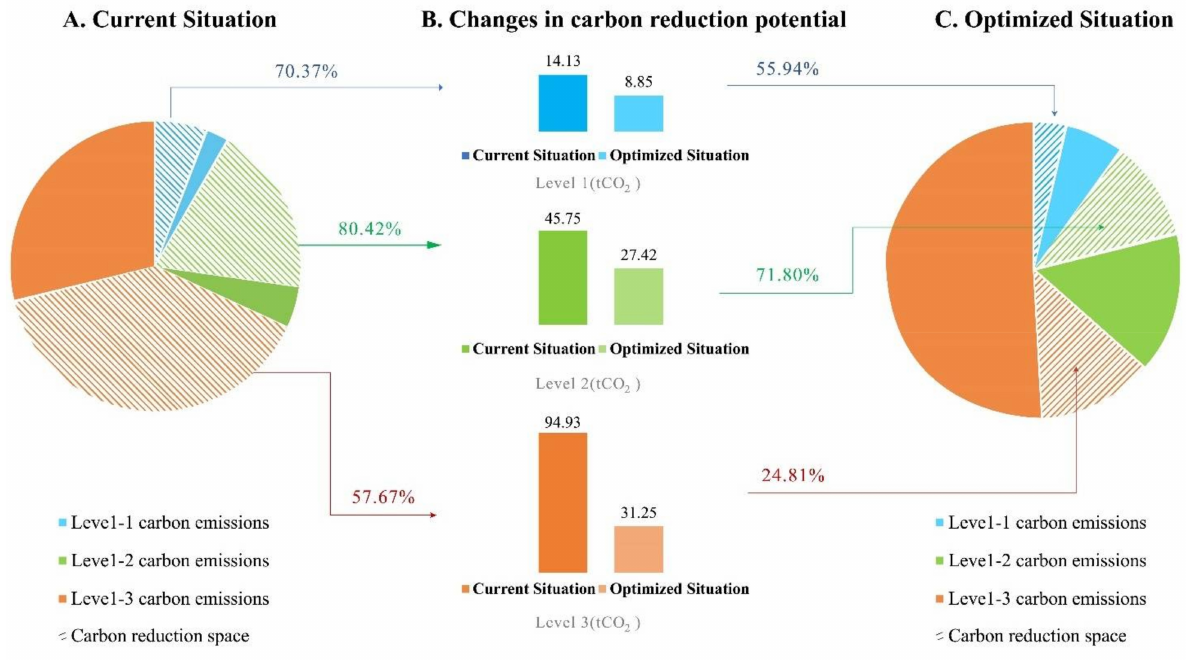
Figure 8. Changes in carbon reduction